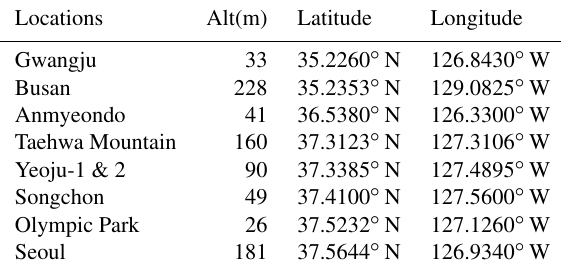
Table 1. KORUS-AQ locations (south to